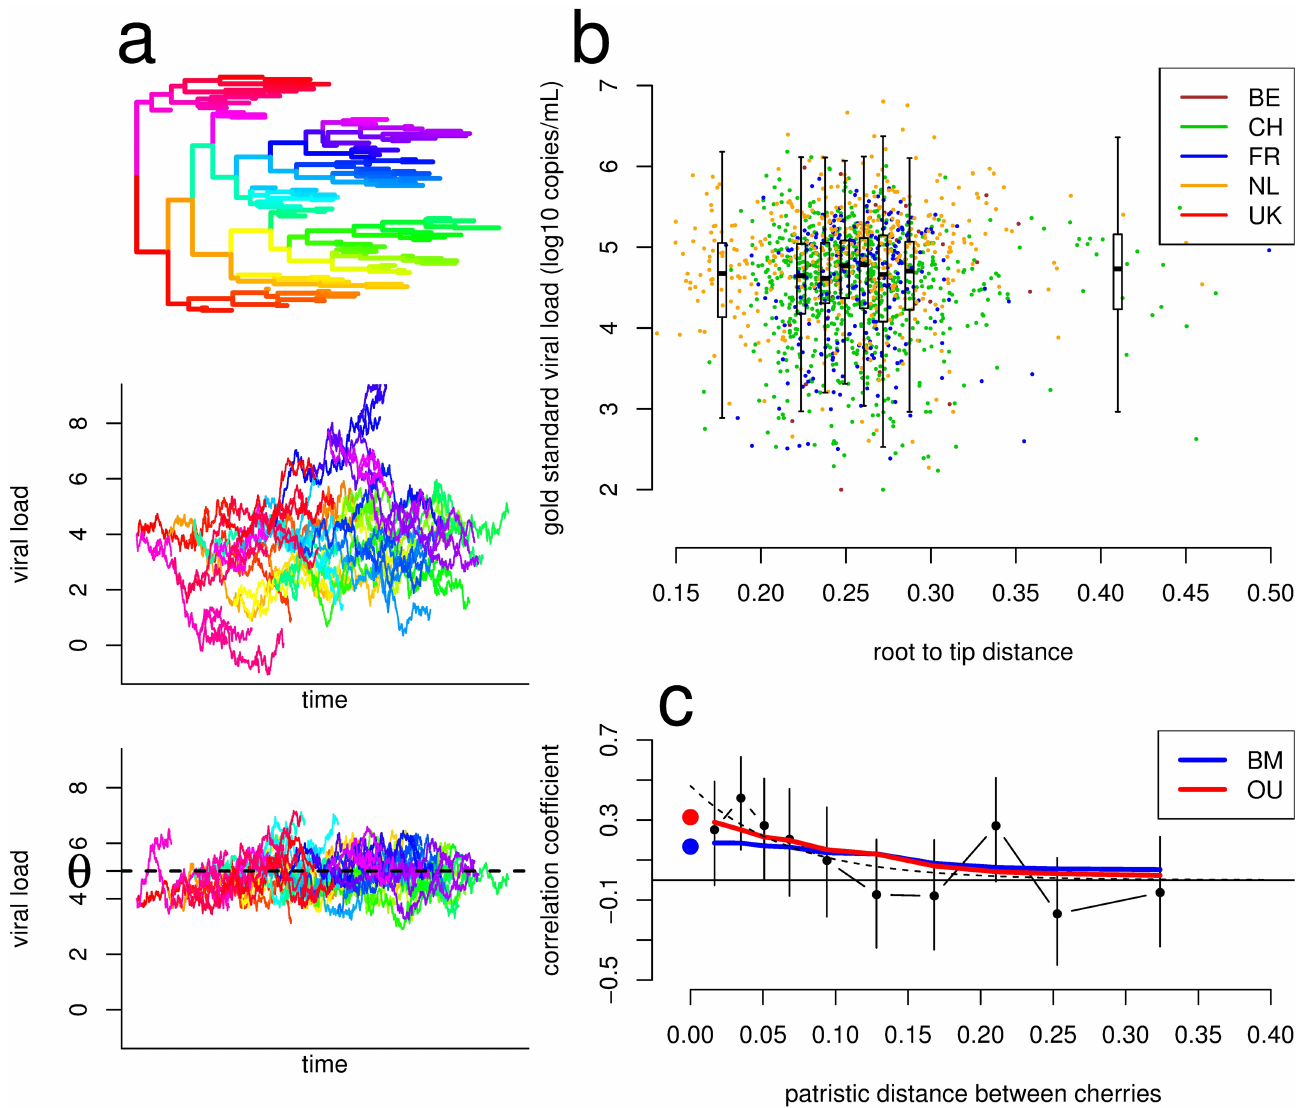
Fig 1. Predictions from the Brownian motion (BM) and Ornstein-Uhlenbeck (OU) models of evolution. (A) Illustration of the models of character evolutionon a phylogeny (top panel), showingunconstrained neutral evolutionleadingto increasing genetic varianceunder the BM model (middle panel)versus stabilizingselectionaroundan optimum θ under the OU model, which results in stable variance over time (bottom panel). Edges of the phylogenywere arbitrarily colored for illustrative purposes. (B) The distribution of gold standard viral load (GSVL) over evolutionary time (as quantified by root-to-tip distance[i.e., distancefrom the common ancestor as assessed by the phylogeny]). Points are the data; boxplotsshow the median,lower, and upper quartiles, and the whiskers are the lower and upper quartile minus or plus 1.5 times the interquartile range for 8 bins of equal size. (C) The correlationcoefficient of GSVL across 511 phylogenetic cherries in the subtype B phylogeny as a function of the patristic distancebetween cherries. Phylogeneticcherries were groupedby patristic distancein 10 bins of equal size. Points are the data, the dashedline is a decreasing exponentialfit on the data, and thick lines show predictions from the maximum likelihood(ML) BM and OU models. The large points at patristic distance0 show the population-level heritabilityestimated under the BM (blue) and OU (red) model. The data used in the figure are provided as S1